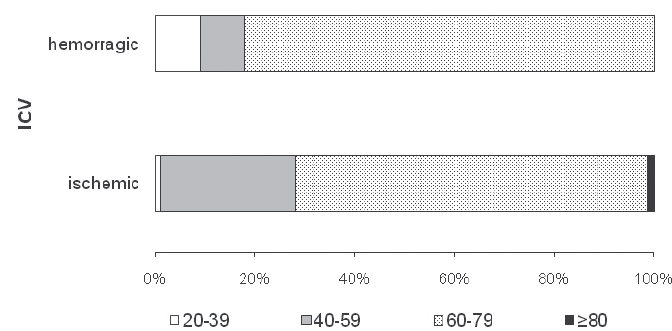
FIGURE 1. Distribution of patients’ age in both